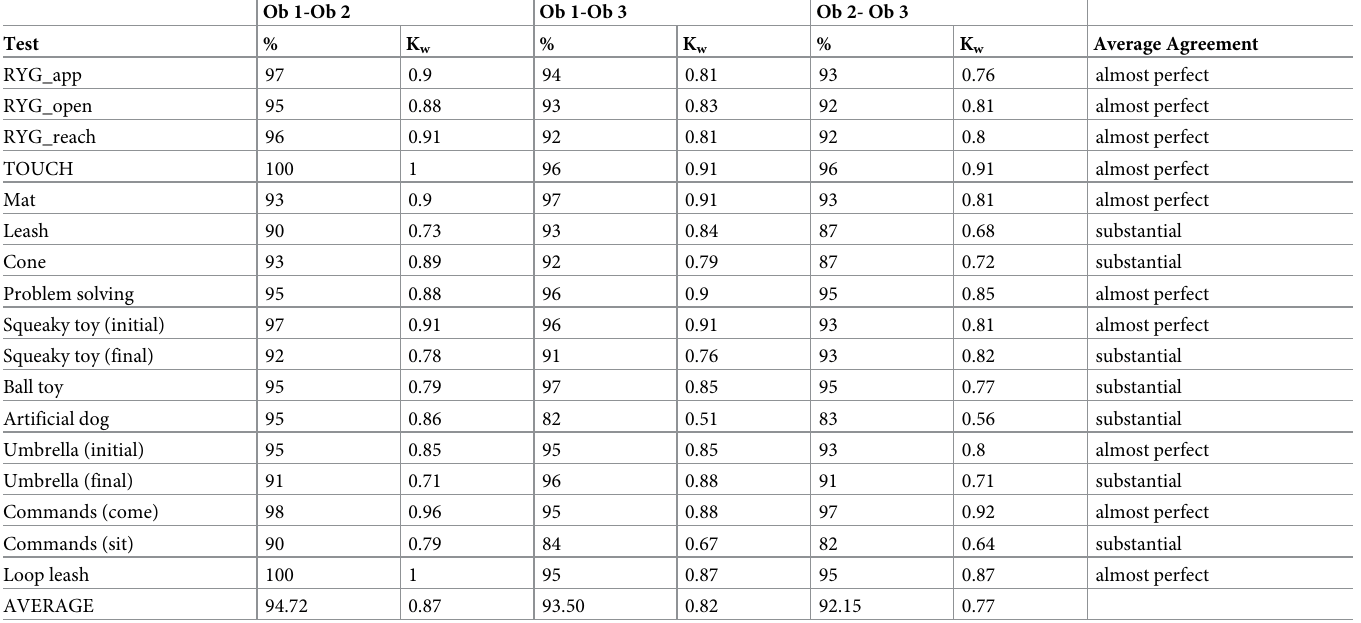
Table 3. Agreement between